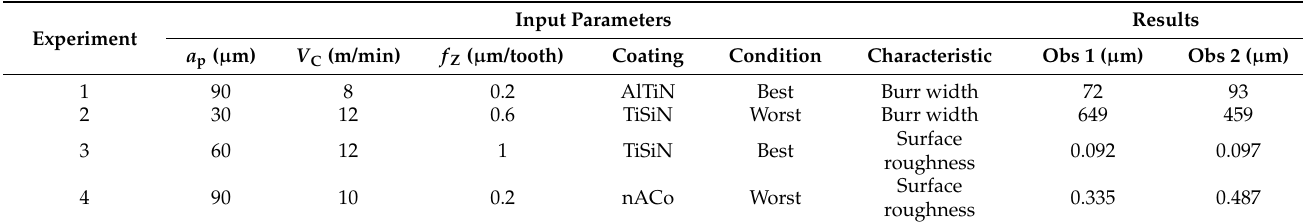
Table 10. Confirmation experiments for the burr and surface roughness tests.